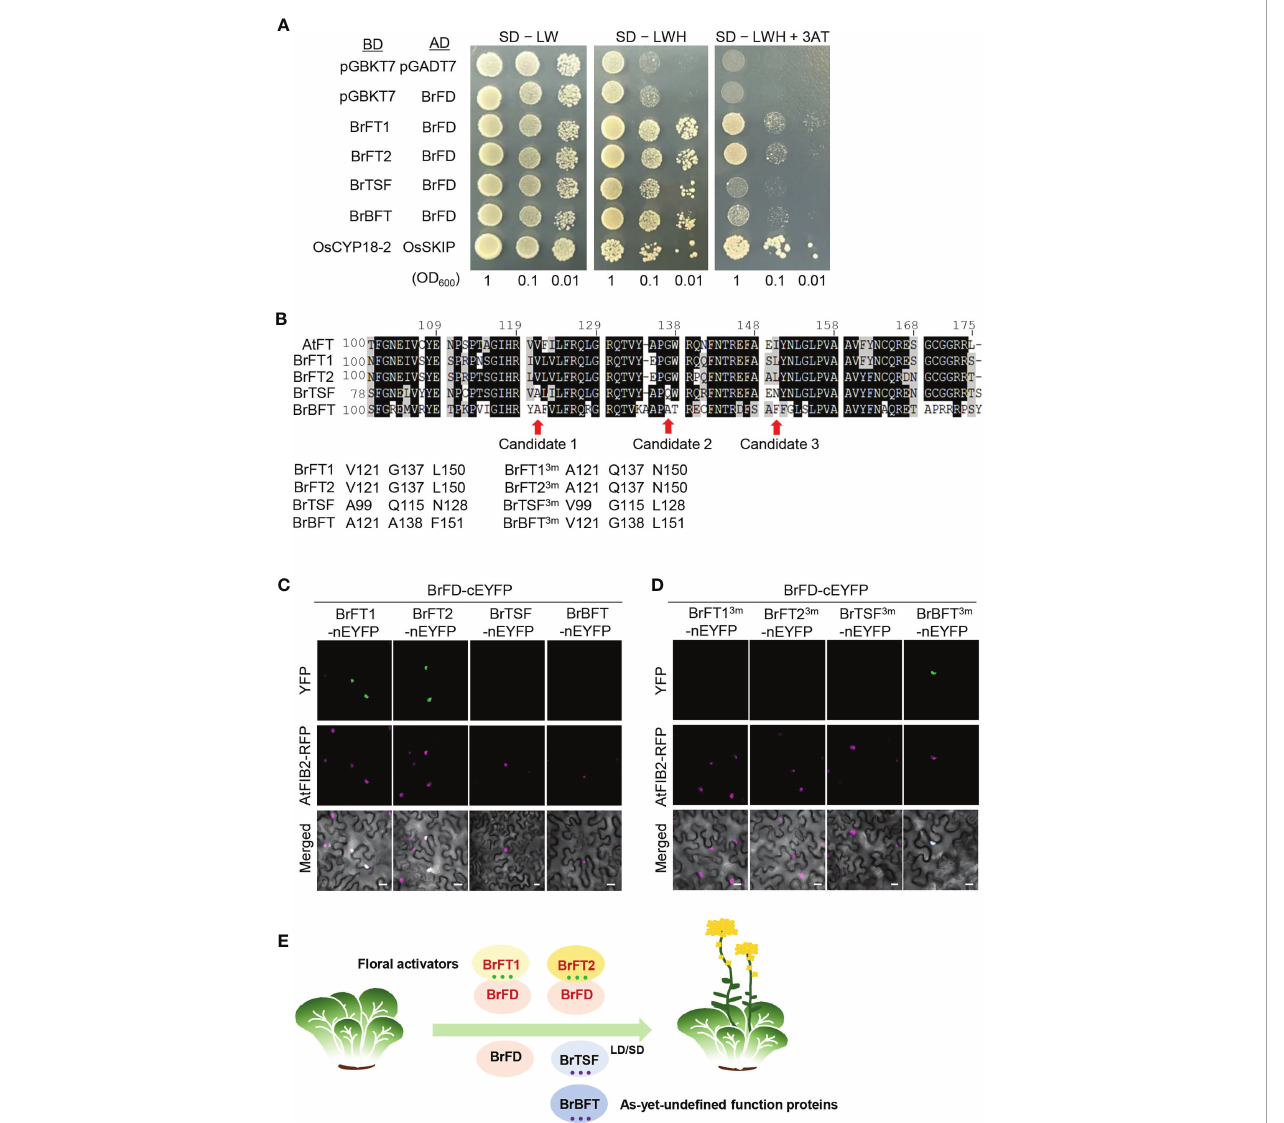
FIGURE 5 Protein – protein interactions between BrFT-like proteins and BrFD. (A) Yeast two-hybrid assays testing the interaction between BrFT-like proteins and BrFD. BrFT-like proteins in the pGBKT7 vector and BrFD in pGADT7 vector were used as bait and prey constructs, respectively. The empty pGBKT7 was used as negative control, and OsCYP18-2 and OsSKIP were used as the positive control. AH109 yeast cells were grown on synthetic de fi ned (SD) medium lacking tryptophan and leucine (SD – LT); SD lacking tryptophan, leucine, and histidine (SD – LTH); and SD medium lacking tryptophan, leucine, and histidine and containing 3 mM 3-amino-1,2,4-triazole (3AT) (Sd – LTH + 3AT). (B) Sequence alignment of the C-terminal domain of AtFT and BrFT- like proteins. Val-121, Gly-137, and Leu-150 were selected as key amino acids that are distinct between AtFT, BrFT1/2, and BrTSF/BrBFT. (C) BiFC assay testing the interactions between BrFT-like proteins and BrFD. Constructs encoding BrFT-like proteins fused to the N-terminal half of eYFP (nEYFP) were co-expressed with a construct encoding BrFD fused to the C-terminal half of eYFP (cEYFP) in N. benthamiana leaves. Scale bars, 20 m M. (D) BiFC assay with constructs encoding BrFT-like proteins harboring three – amino acid substitutions (BrFT 3ms ) fused to nEYFP and co-expressed with a construct encoding BrFD fused to cEYFP in N. benthamiana leaves. Scale bars, 20 m M. (E) A proposed model for the functional diversi fi cation of BrFT-like proteins via their interaction with BrFD. BrFT1 and BrFT2 interact with BrFD to facilitate fl owering. By contrast, BrTSF and BrBFT do not interact with BrFD and do not activate fl